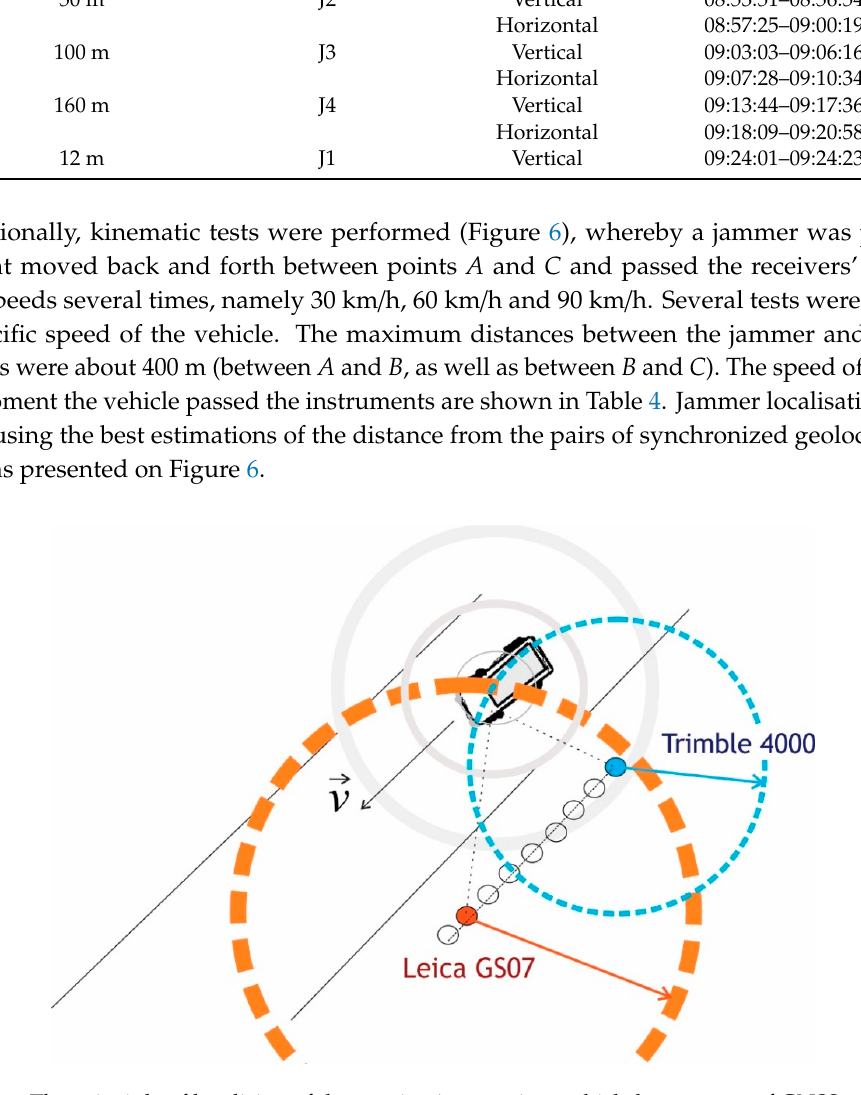
Figure 6. The principle of localising of the moving jammer in a vehicle by an array of GNSS receivers (own study). (own study). Table 4. Jammer’s kinematic disturbances (jammer in the vehicle). Table 4. Jammer’s kinematic disturbances (jammer in the vehicle). Time at Which the Vehicle Time at Which the Vehicle Speed of the Vehicle Speed of the Vehicle Passed the Instruments